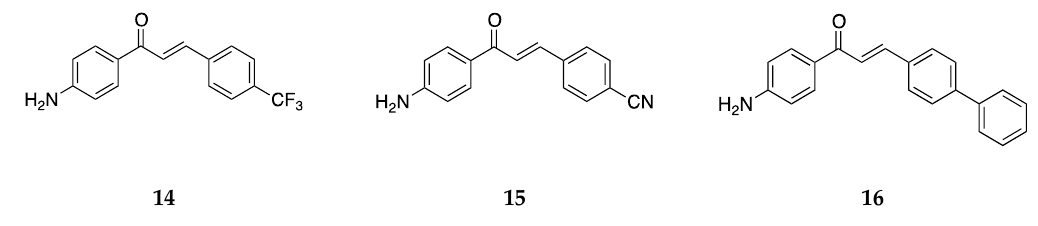
Figure 13. Chemical structures of 4-aminochalcone derivatives.